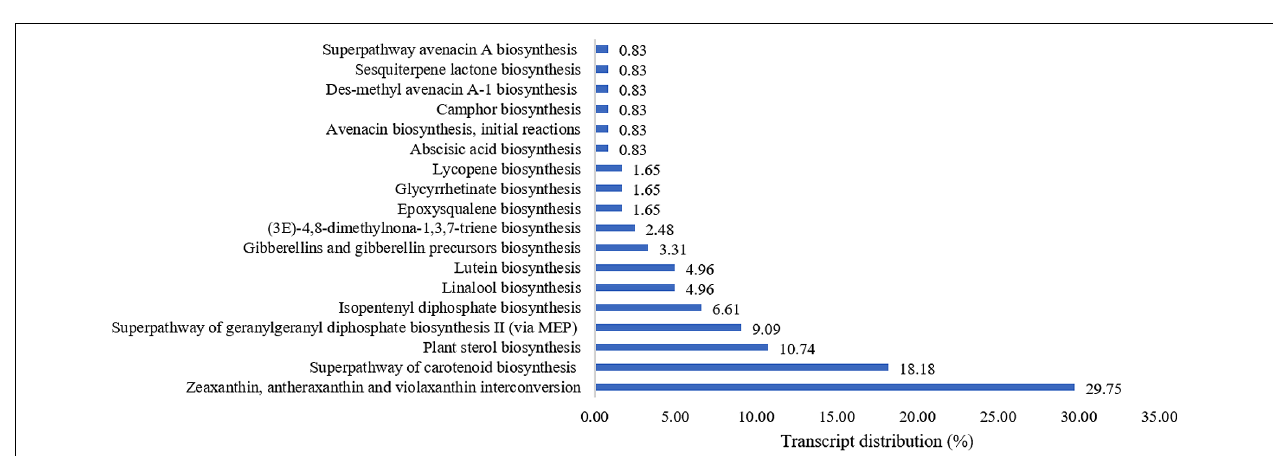
FIGURE 2 | Percentage distribution of terpenoid biosynthesis pathway-related transcripts observed from PlantCyc enzymes annotation (Level